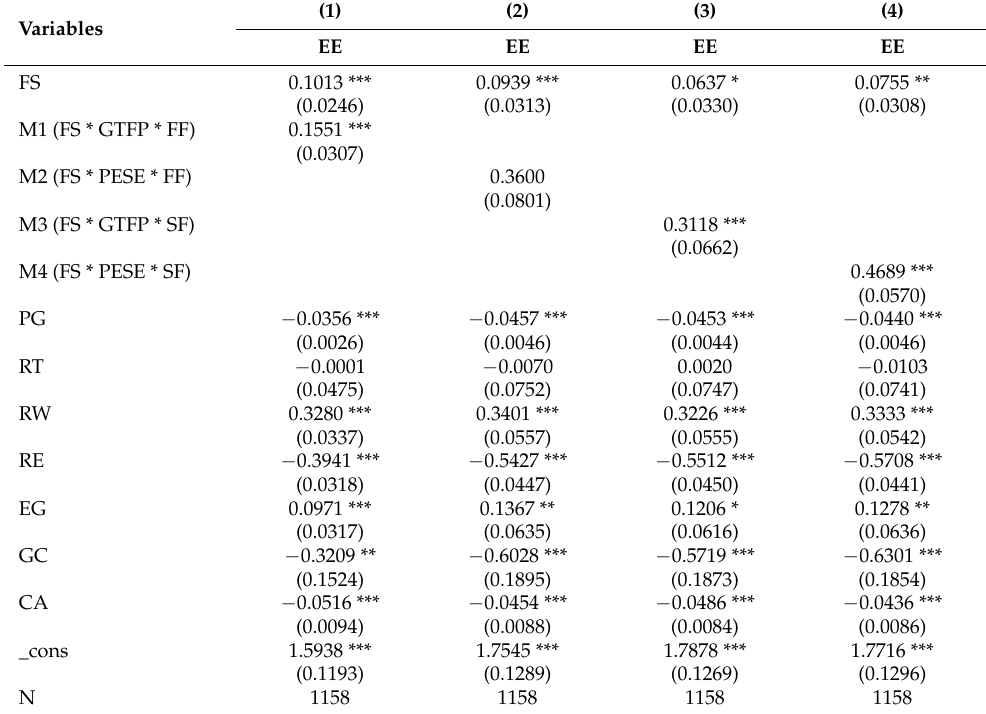
Table 11. Analysis of moderating effect—Fixed Assets Investment Financing